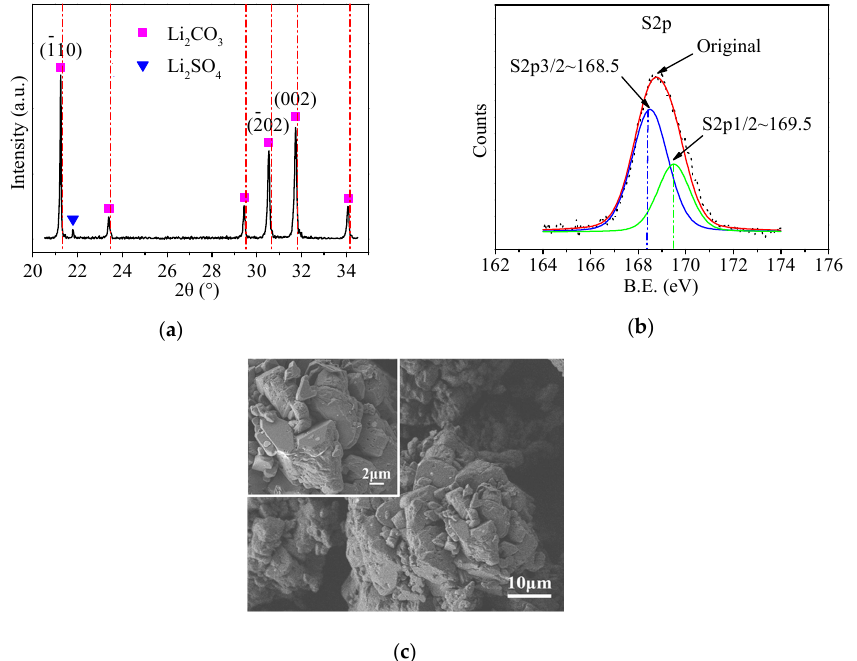
Figure 1. ( a ) XRD, ( b ) XPS and ( c ) SEM patterns of commercial Li 2 CO 3. Figure 1. ( a ) XRD; ( b ) XPS and ( c ) SEM patterns of commercial Li 2 CO 3. Crystals 2018 , 8 , 19